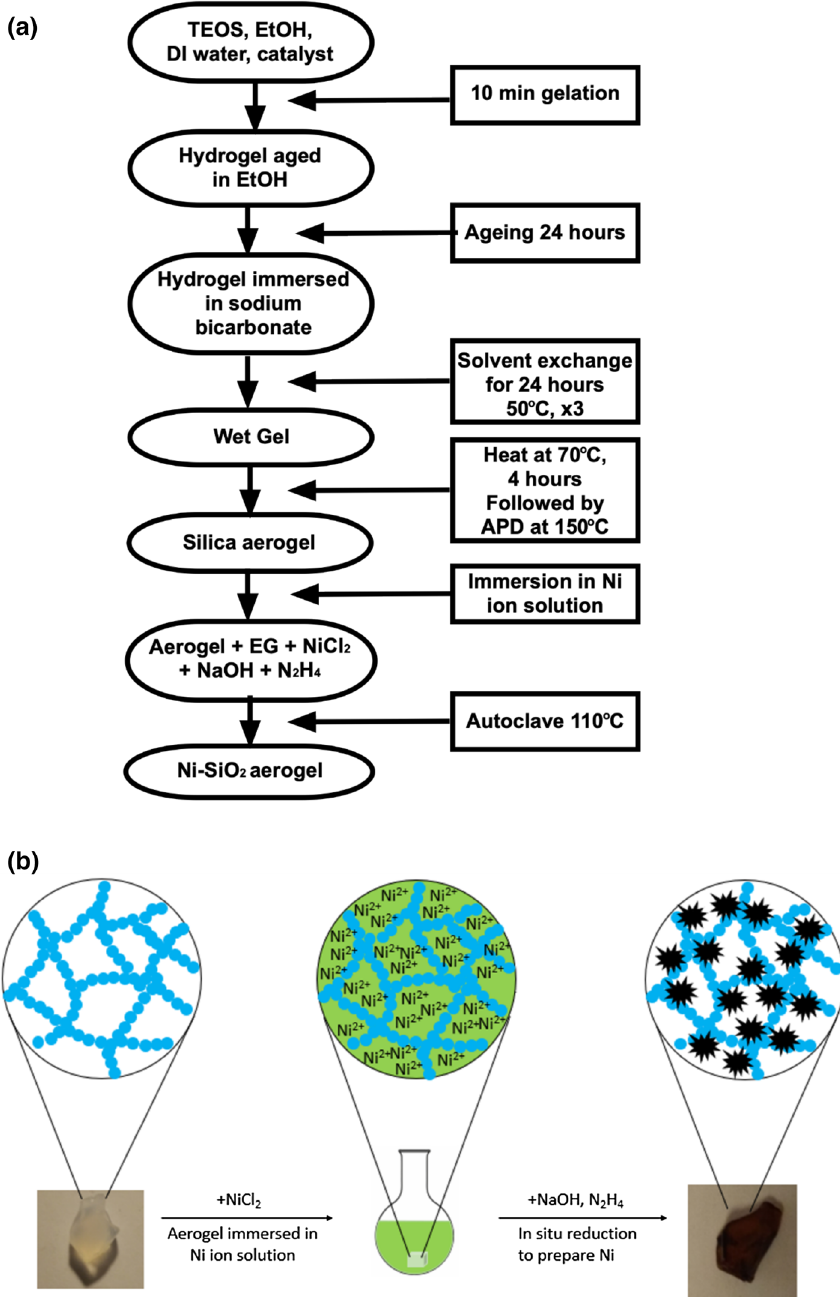
Figure 1. ( a ) Flow diagram illustrating the aerogel preparation process; ( b ) Schematic illustration of the in situ synthesis of Ni within the aerogel, corresponding to the last two steps in ( a